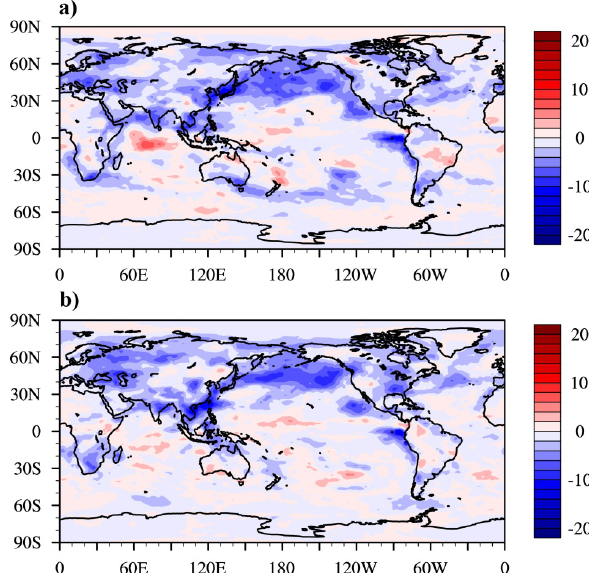
Fig. 3. Model predicted difference in the 10-yr average shortwave cloud forcing (Wm − 2 ) between the ( a) Default-PI and Default and Figure 3. Model predicted difference in the 10 ‐ year average shortwave cloud forcing (W m ‐ 2 ) between the a) between the ( b) G11-PI and G11 Default ‐ PI and Default and between the b) G11 ‐ PI and G11 simulations.